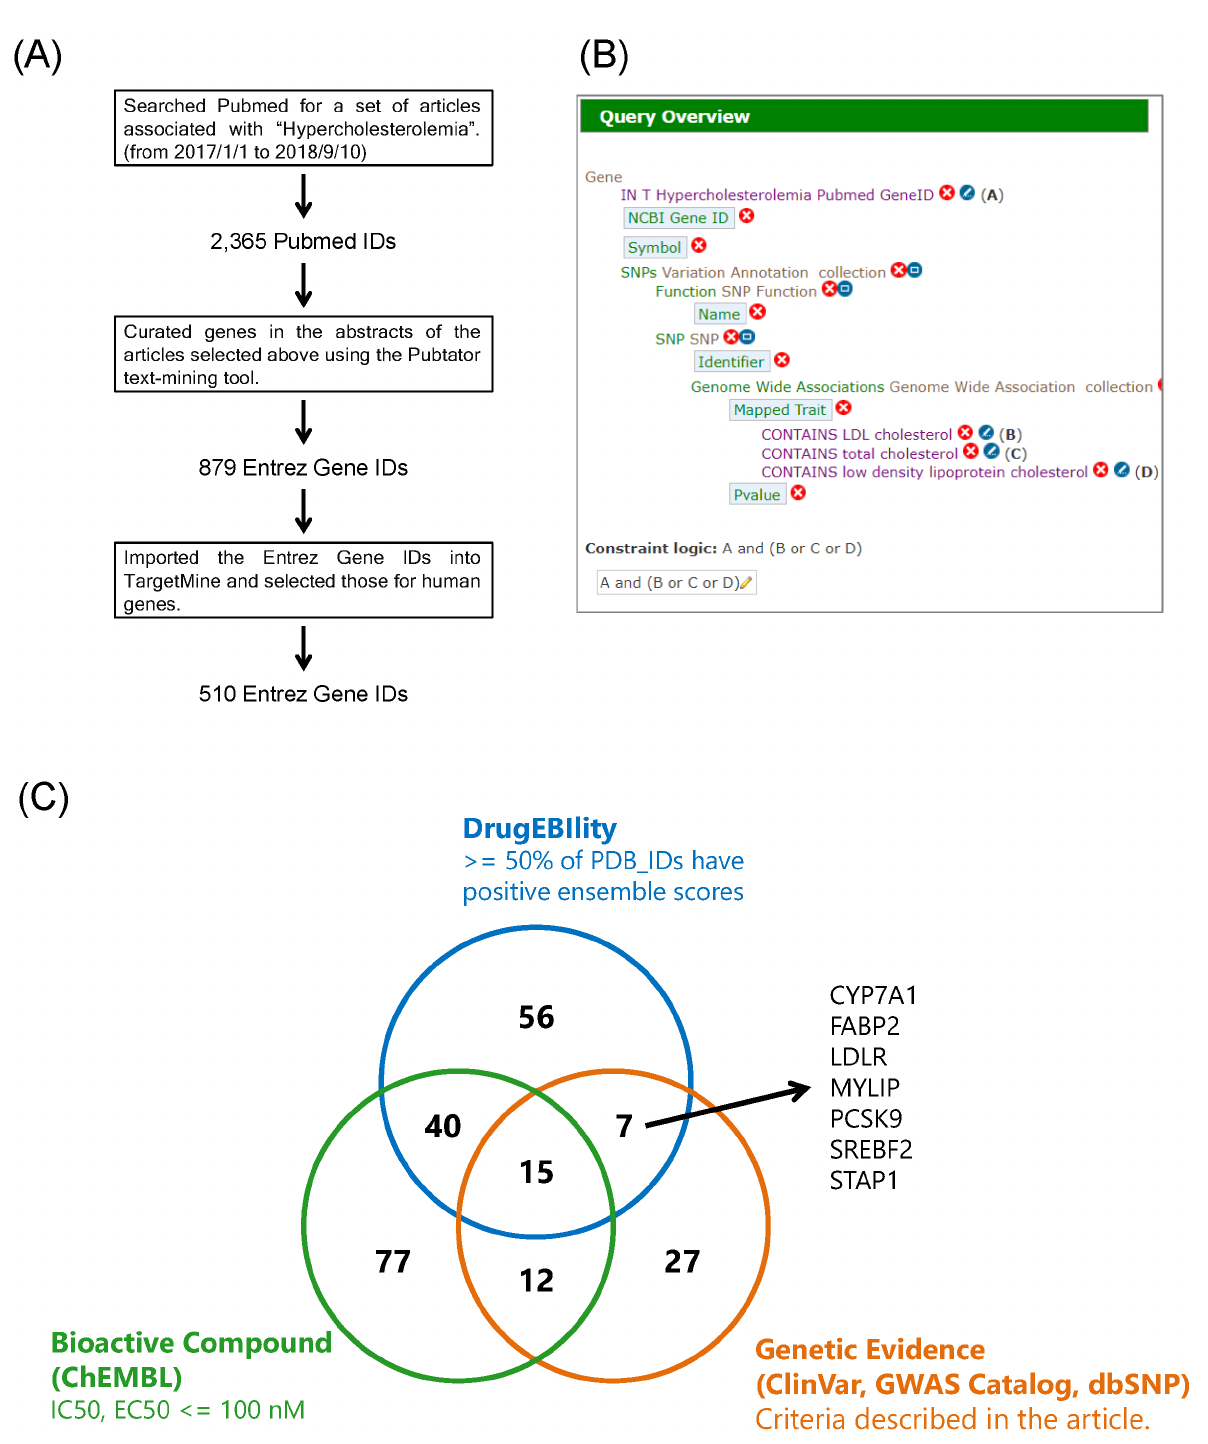
Figure 5. Gathering and prioritizing candidate drug target genes for hypercholesterolemia. ( A ) Gathering hypercholesterolemia- related genes from article information in PubMed. ( B ) The screenshot of the query builder in TargetMine to extract the genes with genetic evidence from GWAS catalog. Other query screenshots used in this prioritization process can be found in the extended data. ( C ) Prioritizing hypercholesterolemia-related genes with TargetMine to identify novel targets for small molecule drugs. Top prioritized genes were defined as those that met all of the following three requirements: 1) more than or equal to 50% of protein 3D structures (PDB IDs) having positive ensemble scores, 2) no potent bioactive compounds (EC50 or IC50 ≤ 100 nM in ChEMBL) and 3) having genetic associations with hypercholesterolemia (for more details, see the Use Cases